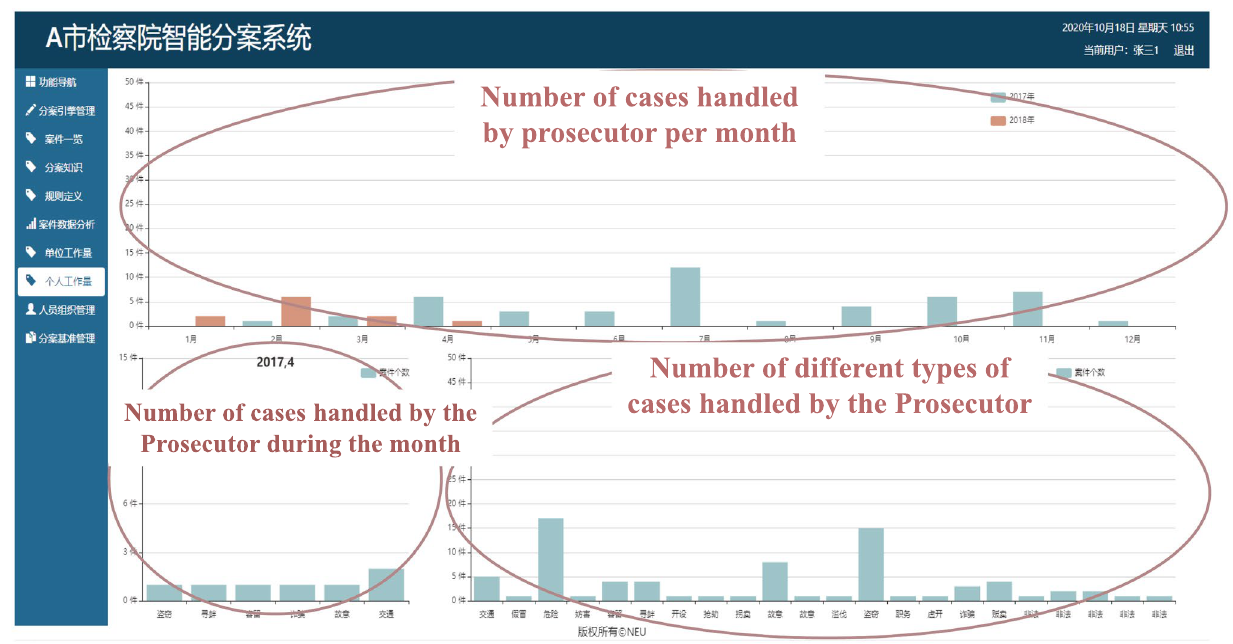
Fig. 7 Estimation and statistics of prosecutors’ personal